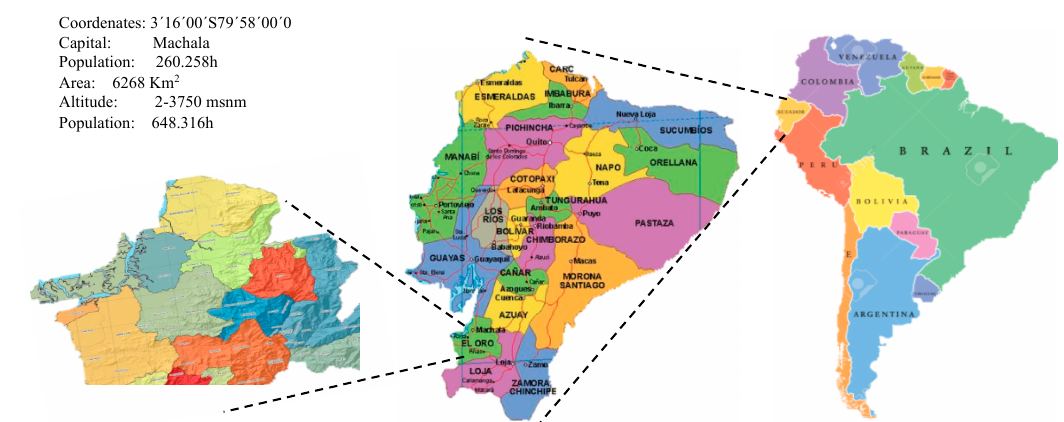
Figure 3. Geo-referenced map of the study area. Figure 3 . Geo-referenced map of the study area